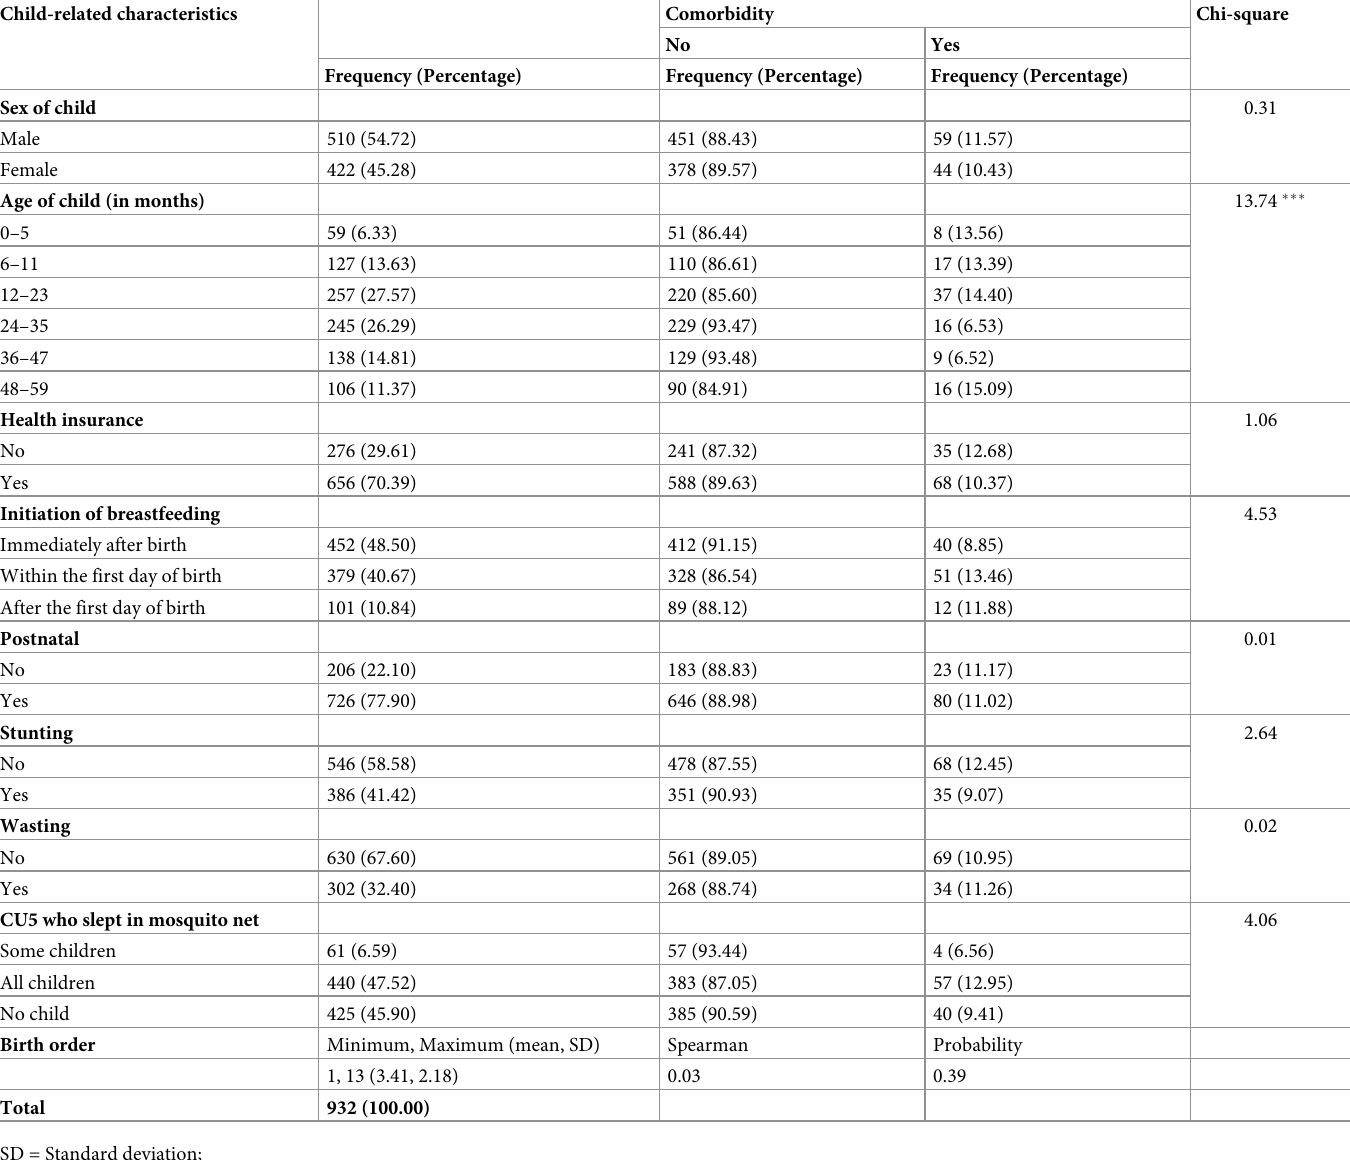
Table 2. Description of child-related